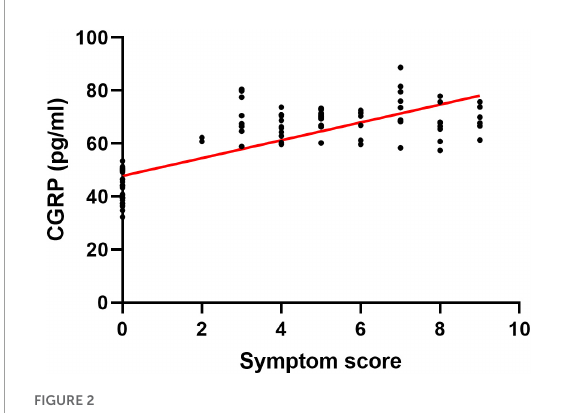
FIGURE2 Relationship between the plasma level of CGRP and the severity of clinical symptoms. Symptom scores correlate positively with plasma CGRP concentrations. CGRP, calcitonin gene-related